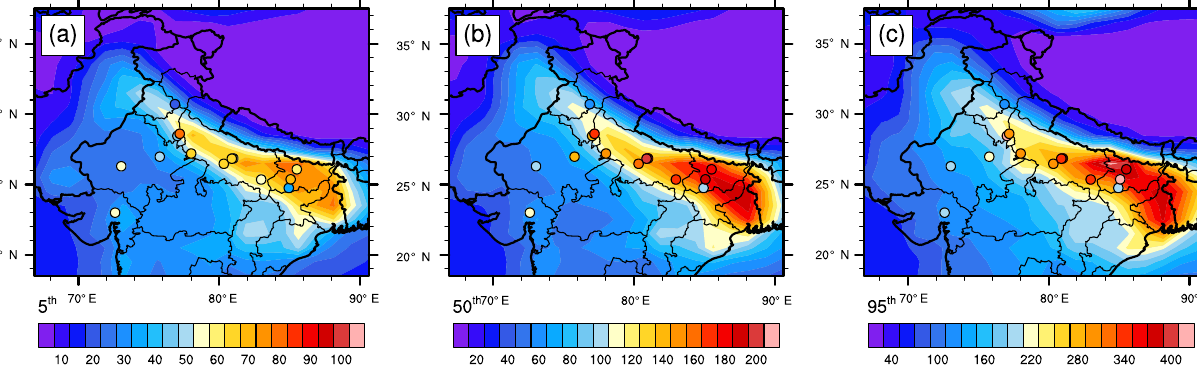
Figure 4. (a) 5th (b) 50th, and (c) 95th percentile of 24h average PM 2 . 5 (µgm − 3 ) over 1 October 2015–31 March 2016 for the observations (circles), and the AM4-CMIP6-wet